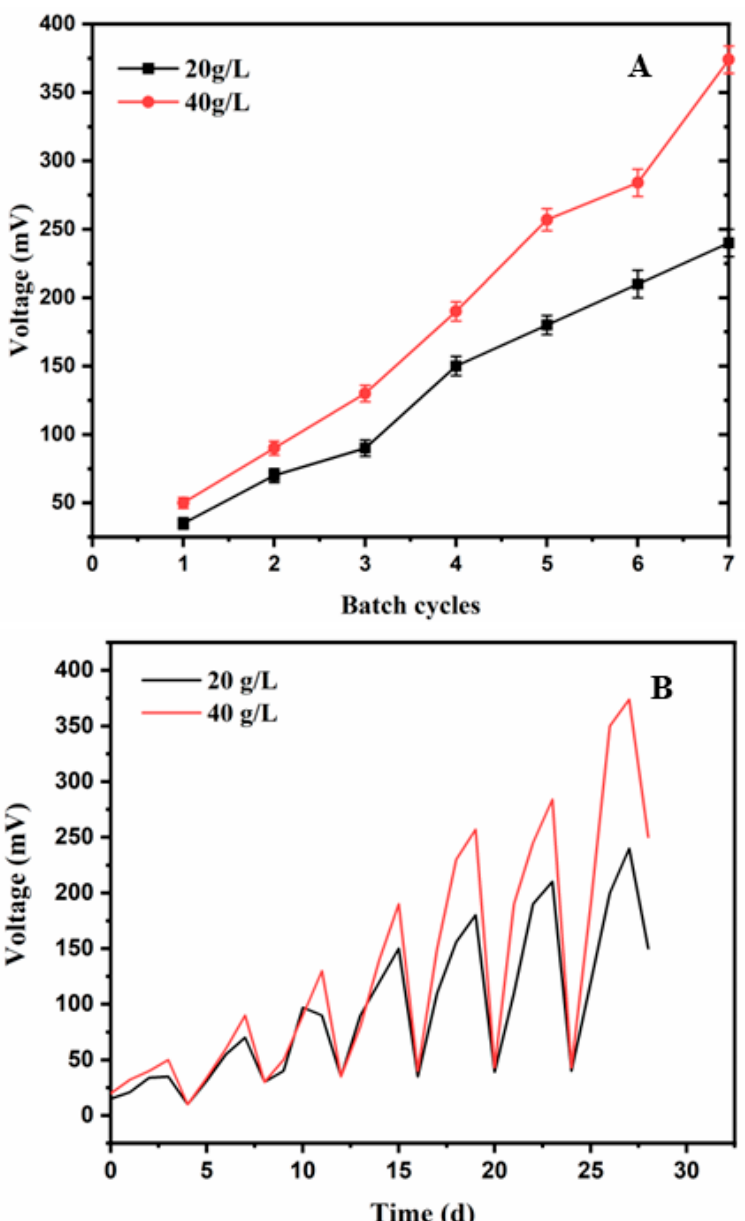
Figure 2. ( A ) Maximum voltage achieved in a cycle versus cycle number during operation of MFC in fed-batch mode ( B ) Voltage v/s time profile over the entire period of MFC operation at different salinities.